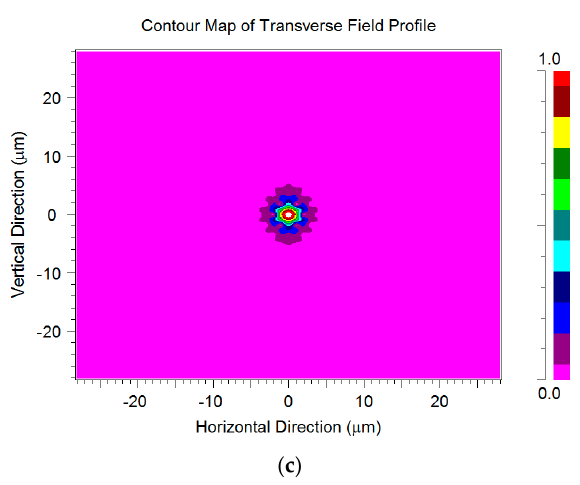
Figure 7. The 8 × 1 power combiner of the optical signals ( λ = 1 µm) of three xy cross sections: ( a ) z = 0 mm; ( b ) z = 2.6 mm; ( c ) z = 5.8 mm.